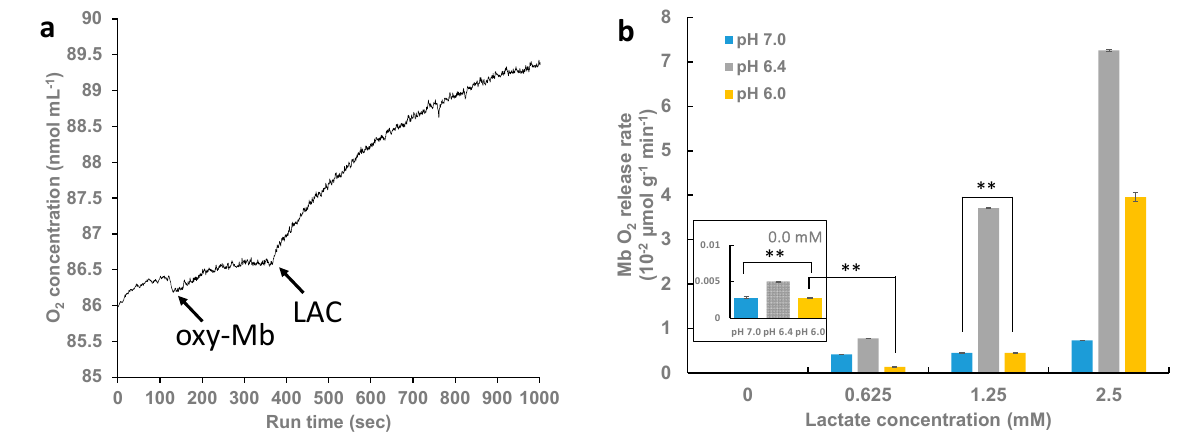
Figure 4. Effect of lactate binding to oxy-Mb and O 2 release kinetics. Oxygen kinetics is studied using Oxytherm+ respirometer. All experiments were performed with 50 mM sodium phosphate buffer (pH 7.0, pH 6.4, and pH 6.0) containing 150 µM equine oxy-Mb and varying concentrations of lactate (0.625 mM to 2.5 mM) and oxy-Mb alone as a control. ( a ) A representative graph showing addition of lactate eliciting a rapid release of O 2 from oxy-Mb at pH 6.4. Arrows in the figure indicate the point of addition of oxy-Mb and LAC into buffer during the run. ( b ) Rate of release of O 2 from Mb against lactate concentrations with buffers (pH 7.0, pH 6.4, and pH 6.0). Inlet chart displays rate of release of O 2 from deoxy-Mb alone (pre-LAC) conditions. All O 2 kinetic experiments were repeated 3 times ( n = 3). Statistical analysis was performed using one-way ANOVA and the Tukey–Kramer post hoc test. Statistical analysis revealed no significant difference in O 2 release from oxy-Mb alone (without LAC) at pH 7.0 and pH 6.0. Additionally, no significant difference in O 2 release was observed at pH 7.0 and pH 6.0 with 1.25 mM LAC condition. Moreover, with the addition of 0.625 mM LAC to oxy-Mb at pH 6.0, no significance difference in O 2 release was observed when compared to oxy-Mb alone at pH 6.0. Among all the test groups, only statistically not significant groups are shown with horizontal lines and two asterisks.